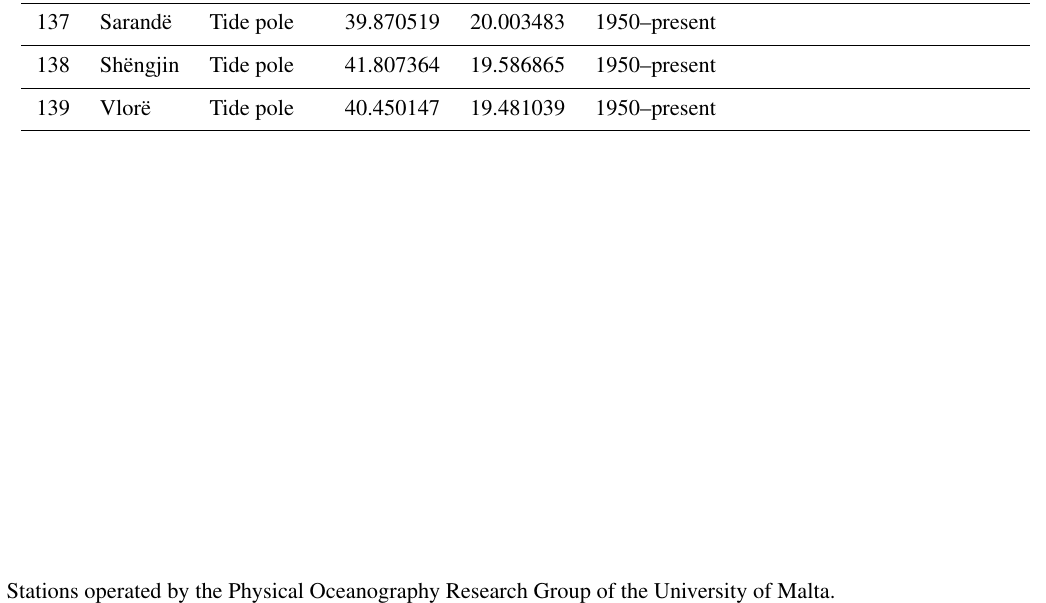
Table A15. Stations operated by the Physical Oceanography Research Group of the University of